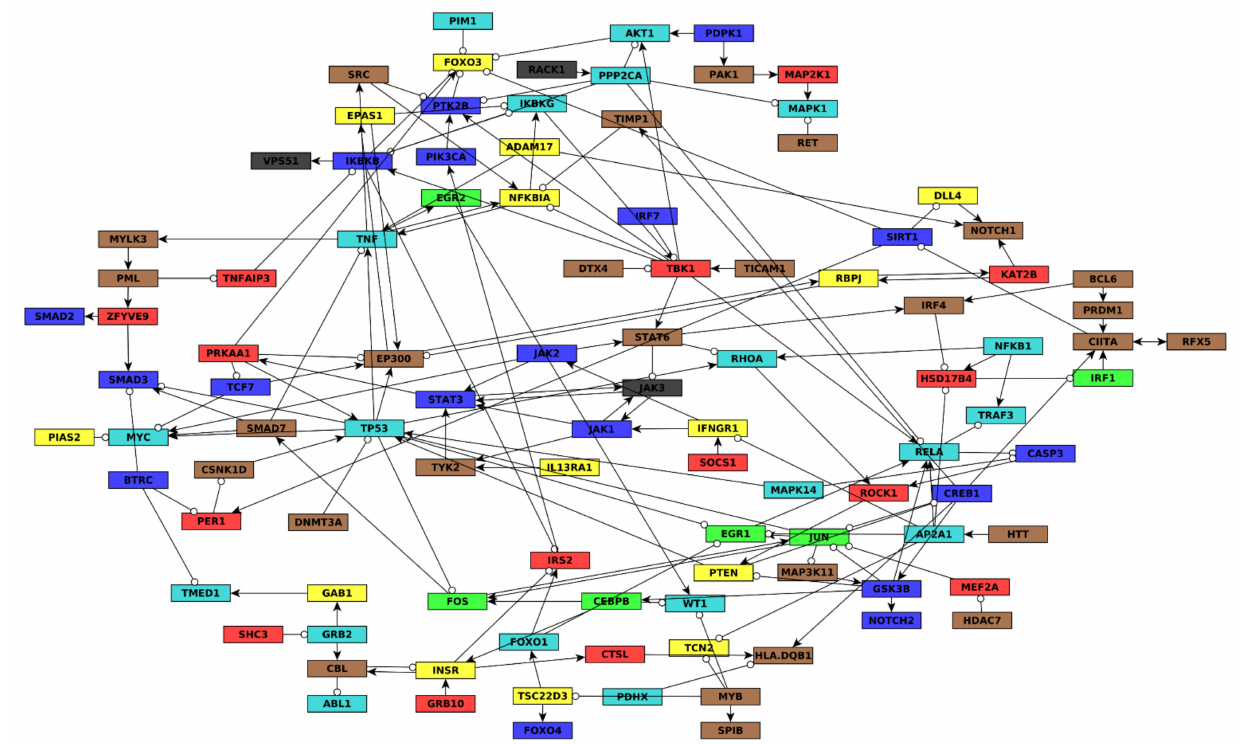
Figure 2. Gene regulatory network of FLT -ITD AML quizartinib and dexamethasone response. Nodes are genes and are colored by the WGCNA module to which they belong. Edges ending in arrows represent net positive regulation, while edges ending in circles indicate net negative regulation. Edge regulation sign is determined using the BooleaBayes algorithm (see Methods Sections 2.5 and 2.6). The nodes in this network combine the transcript and the protein encoded by the same gene. For example, the node JUN has transcriptional regulators (FOS, CREB1, and MEF2A) and a posttranslational regulator (GSK3B). For nodes like this with post-translational modifications, the full network, shown in Figure S10, has separate nodes corresponding to their transcript and active